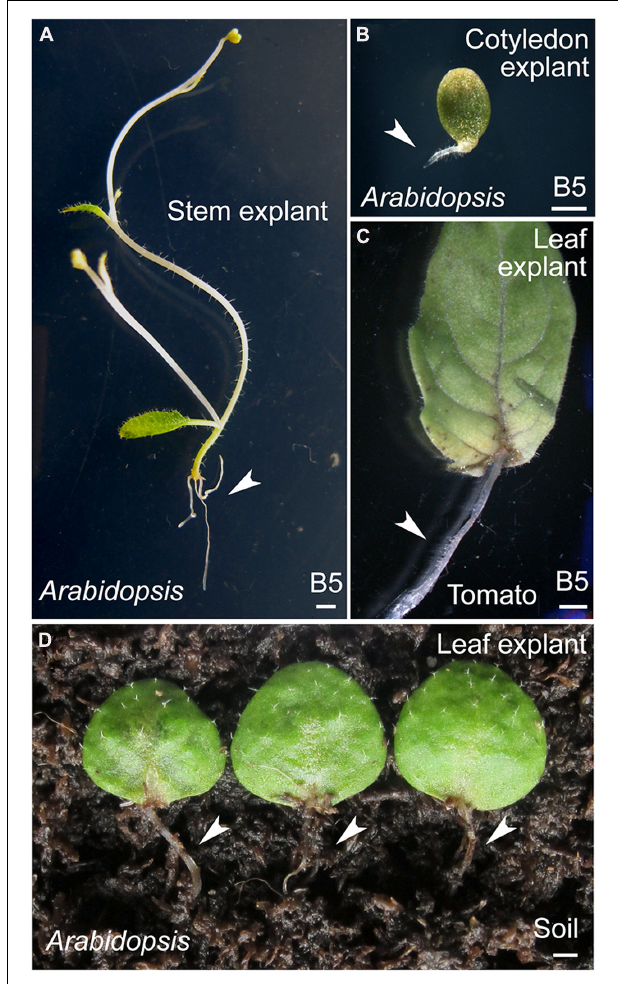
FIGURE 5 | Regeneration of adventitious roots from Arabidopsis organs and tomato leaves. (A,B) Regeneration of adventitious roots from stem (A) or cotyledon (B) explants of 20-day-old or 7-day-old Arabidopsis seedlings, respectively. (C) Regeneration of adventitious roots from tomato leaflet explants. Leaflet was detached from the first pair of compound leaves of 15-day-old seedlings. (D) Regeneration of adventitious roots from leaf explants of 15-day-old Arabidopsis seedlings on surface of wet soil. Of 90 leaf explants tested, 48 had regenerated adventitious roots at 15 DAC. Arrowheads in (A–D) indicate adventitious roots regenerated from explants. Scale bars: 1 mm in (A–D)